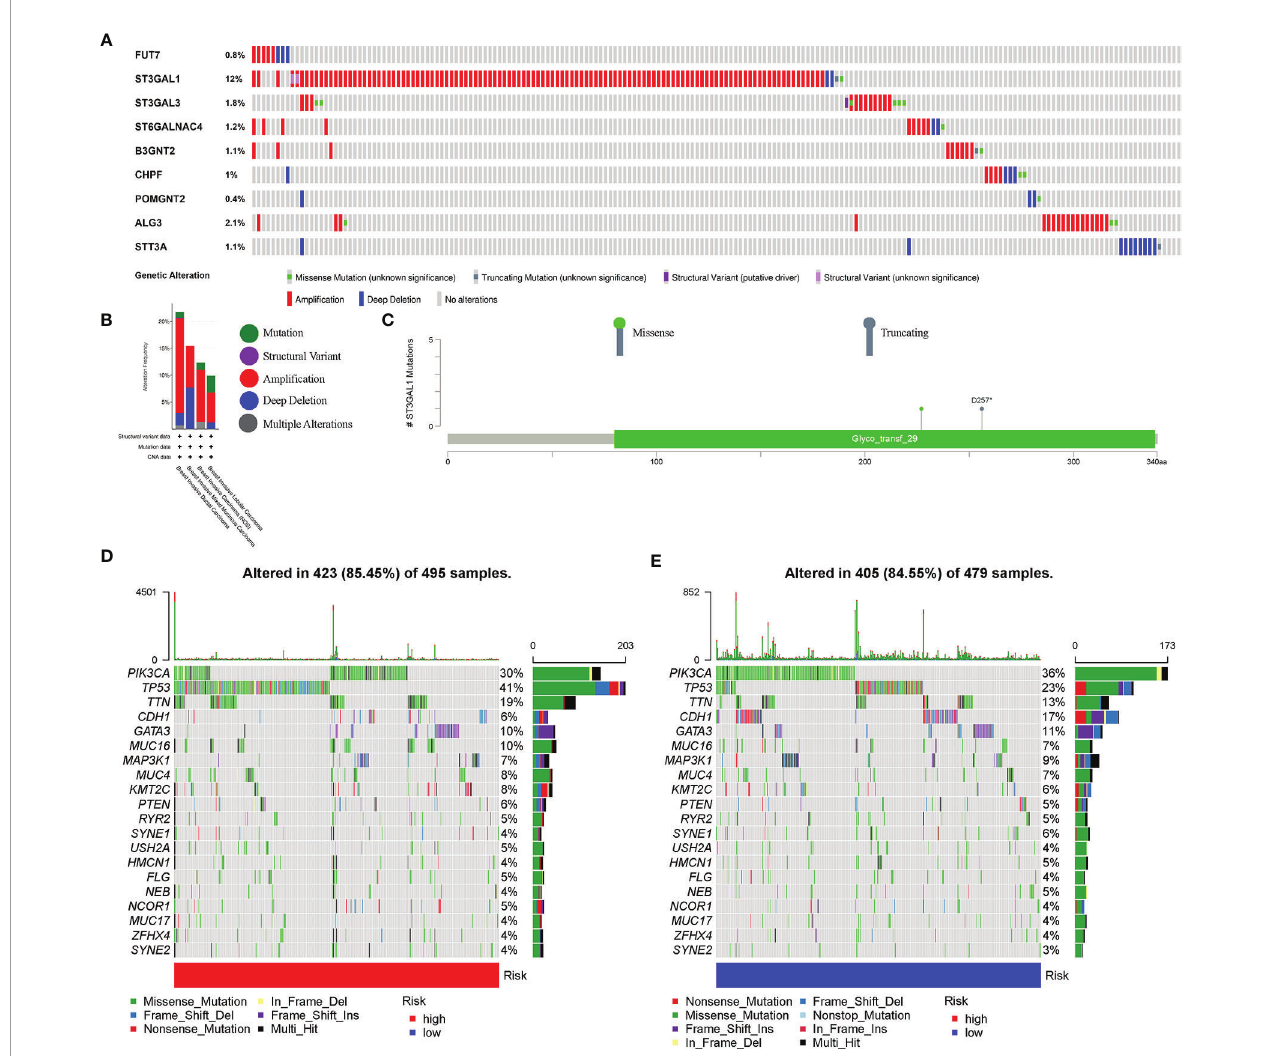
FIGURE 7 | Genetic alterations in BC patients. (A) Mutation and copy number alteration (CNA) analysis of 9 selected glycosyltransferase genes. (B) Frequency of mutation and CNA in glycosyltransferase genes in 4 types of BC patients. (C) Mutation distribution in the functional domains of ST3GAL1. The 20 high-ranking genes with the highest mutation frequency in the high-risk (D) and low-risk groups (E) . BC, breast